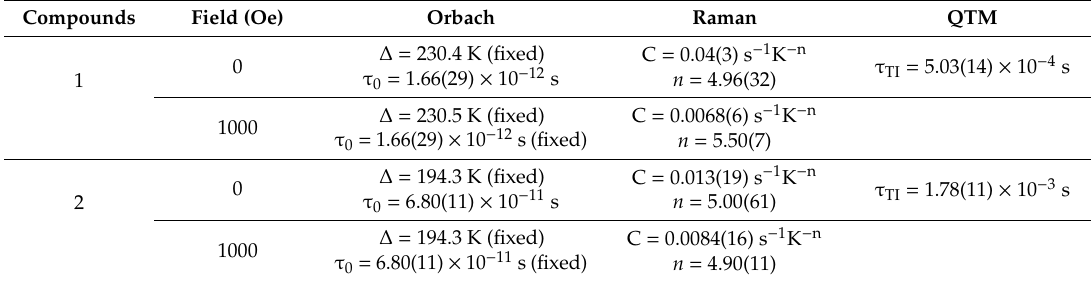
Figure 6. Temperature dependences of the relaxation times ( τ ) at 0 Oe (full black circles) and 1200 Oe (open black circles) for 1 and at 0 Oe (full blue circles) and 1000 Oe (open blue circles) for 2 . Full and dashed lines are the best fitted curves with the parameters given in the text. Table 1. Dynamic parameters of the di ff erent relaxation mechanisms for 1 and 2